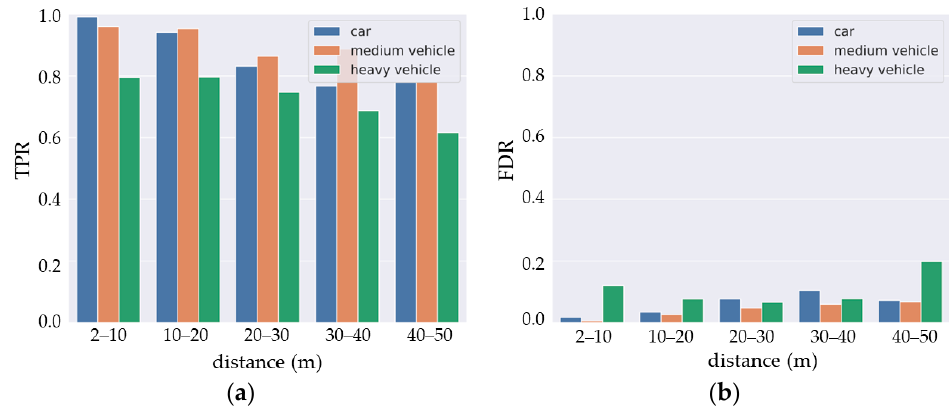
Figure 11. DCNN detection results: ( a ) true positive rate and ( b ) false discovery rate.